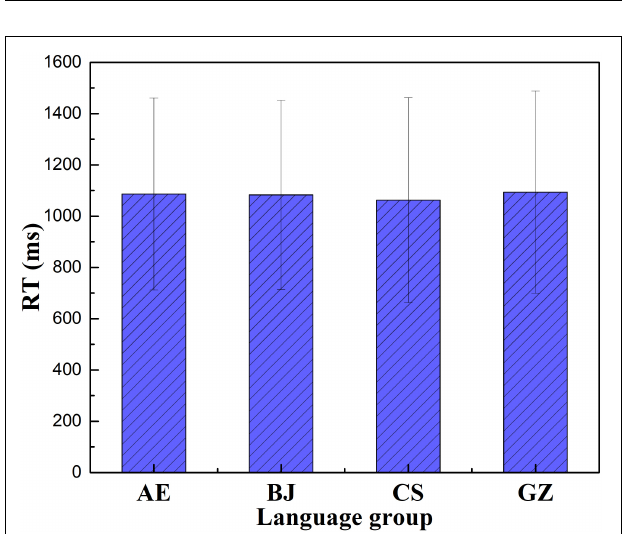
FIGURE 8 | Average participant stimuli reaction time